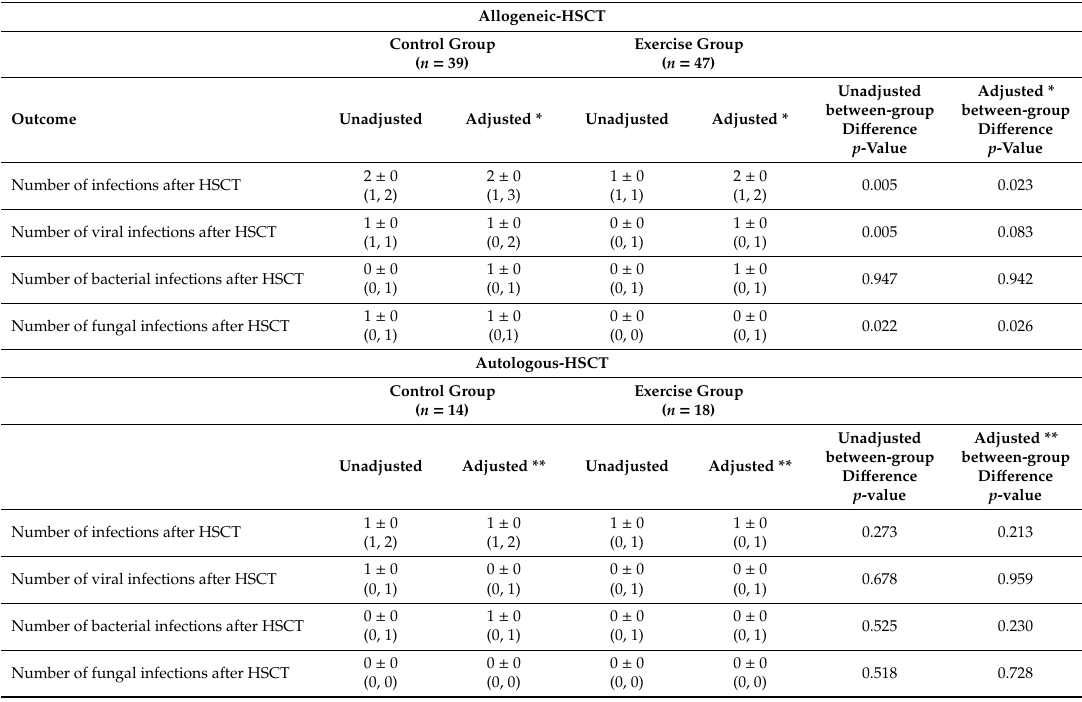
Table 6. E ff ects of exercise intervention on secondary outcomes (number of infections per child).